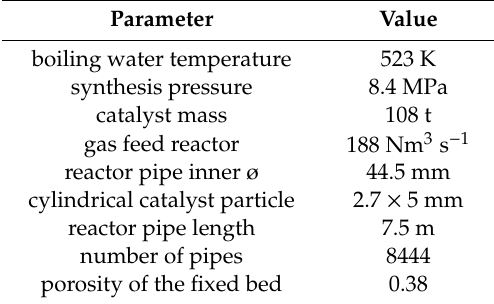
Table 1. Parameters of the reactor